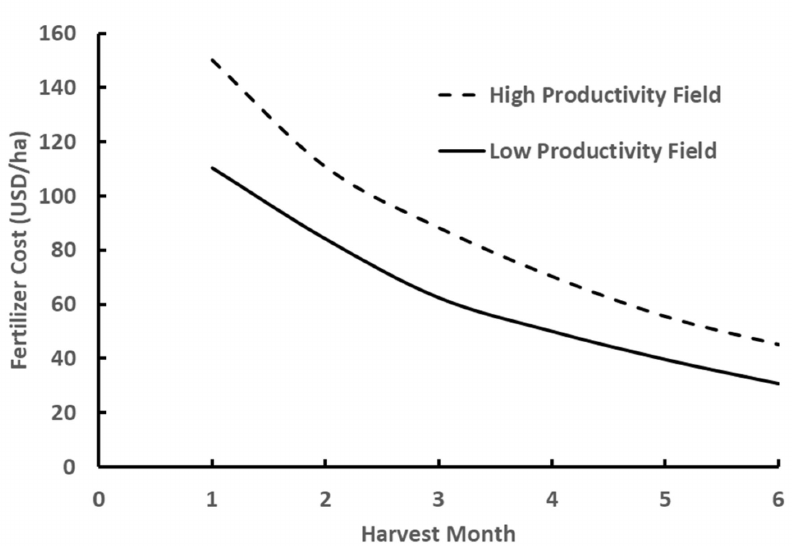
Figure 2. Nitrogen fertilizer replacement cost for biomass harvested under high- and low-productivity site conditions in the Virginia Piedmont when switchgrass is harvested from (1) September through (6)